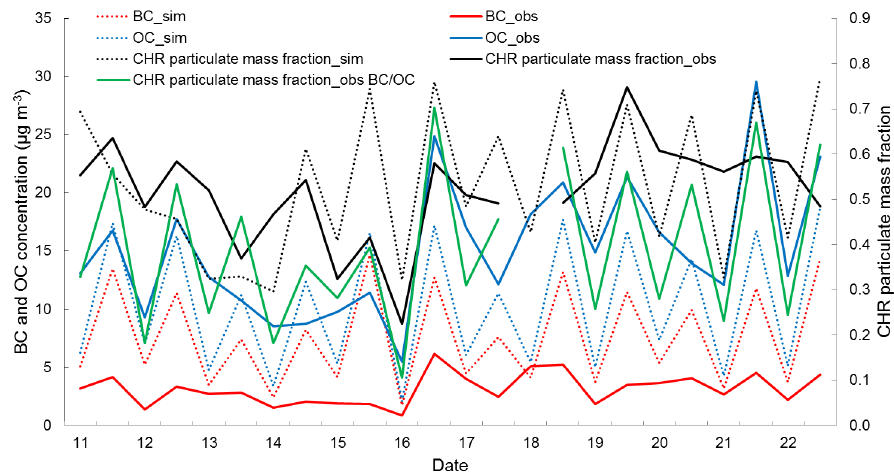
Figure 4. Simulated and observed BC, OC and particulate mass fraction of CHR at the Xianghe site during 11–22 July 2013 (10h means). Calculated particulate mass fraction of CHR based on observed BC and OC is shown at the green solid line. Calculation explained in the